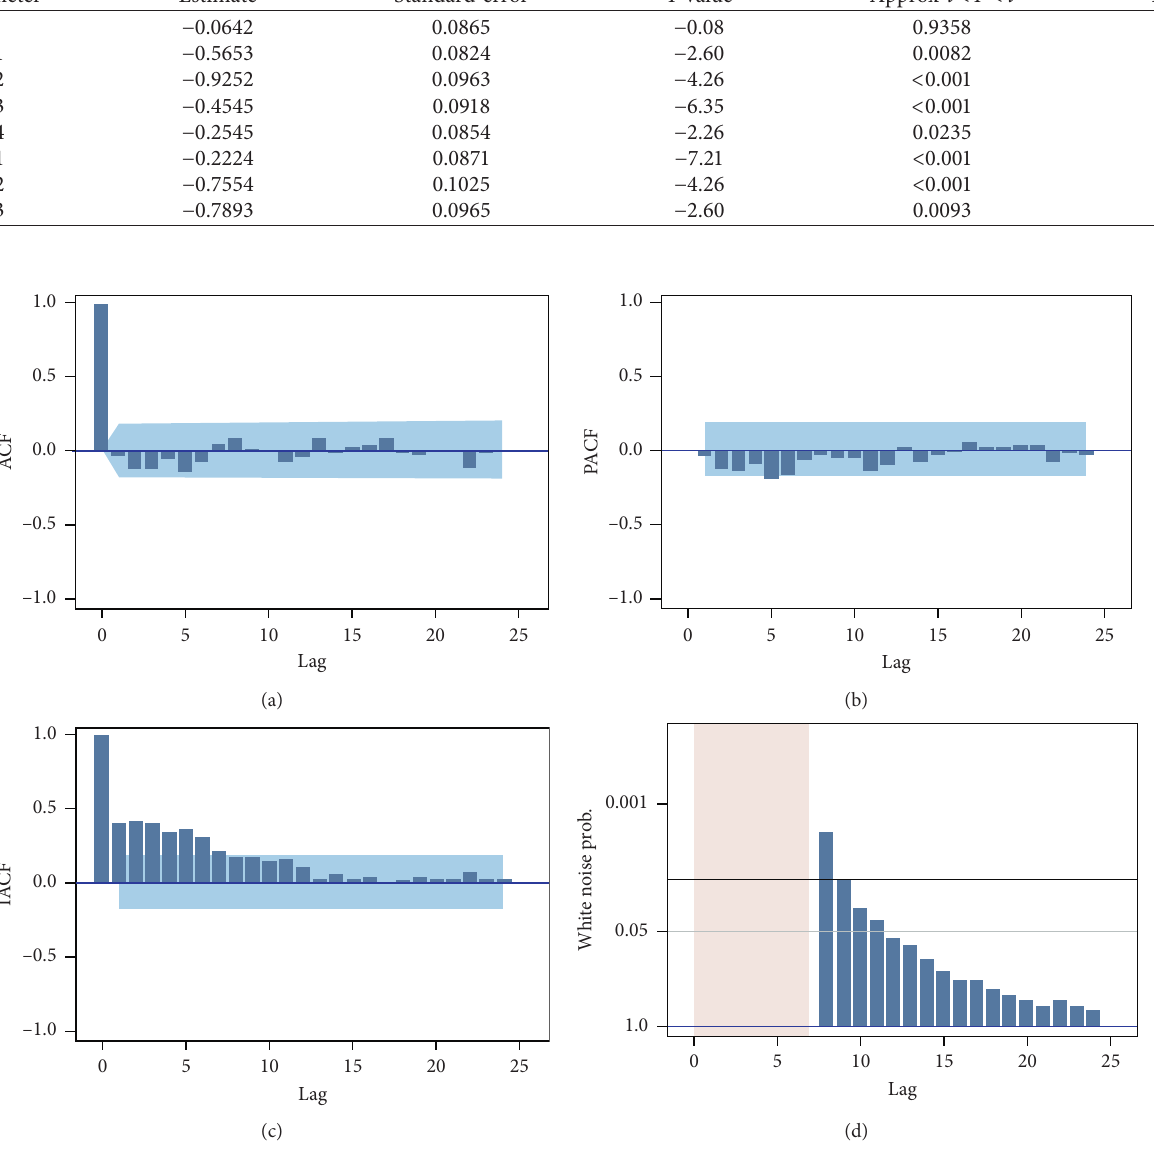
Figure 6: Autocorrelation test chart of fintech ARIMA model residuals.